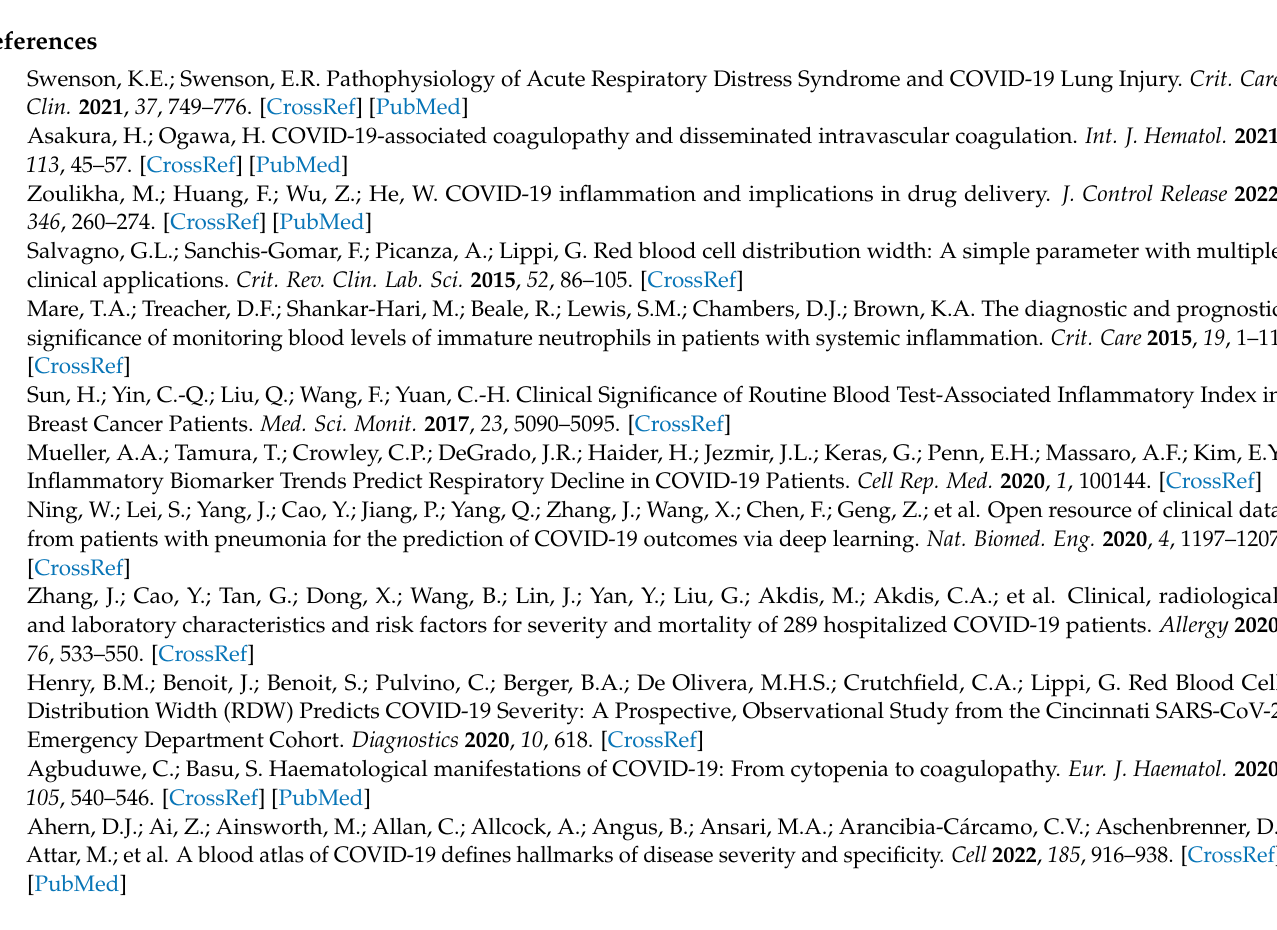
Table S3: Serial changes in blood-cell-count- and CRP-derived inflammatory indices in COVID-19 patients from day 1 to day 30 from the symptom onset; Table S4: Summary statistics of the results of ROC